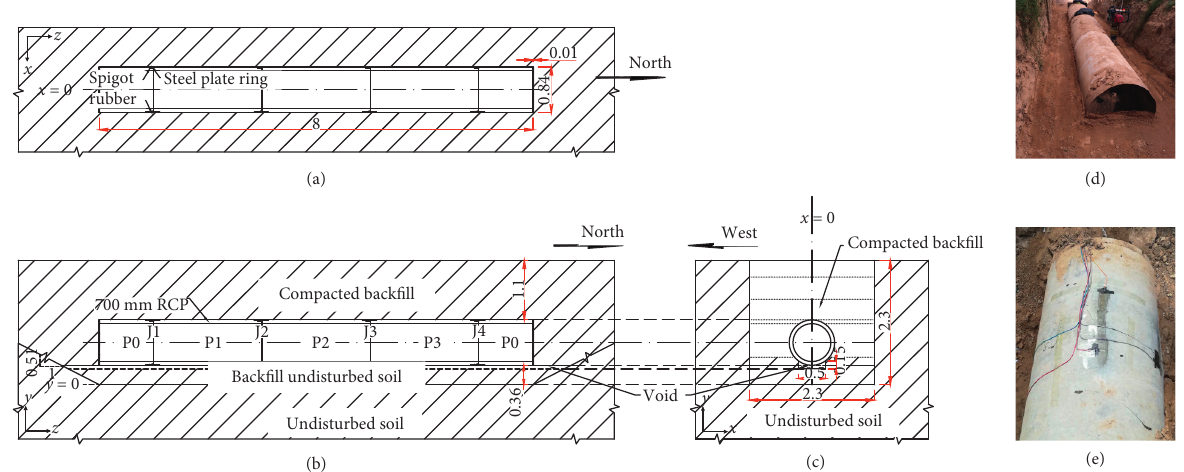
Figure 8: Sectional view of the experimental pipeline and the pictures of the field experiment: (a) plan view, (b) north-south section view (through the cross-section of the pipeline), (c) east-west section view (unit: meter), and (d, e) pictures of the field experiment.